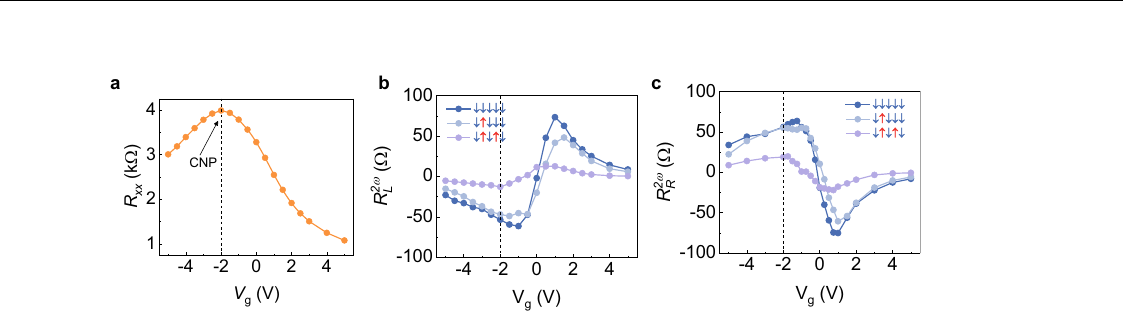
Fig.5|Gatetunabilityofnon-reciprocalresistanceatdifferentmagneticstates in 5-SL MnBi 2 Te 4 . a Longitudinal resistance of the 5-SL MnBi 2 Te 4 as a function of the top gate voltage under zero magnetic fi eld. The measurement is carried out at 11K.Theresistanceshowsamaximumatthechargeneutralitypoint(CNP)withthe